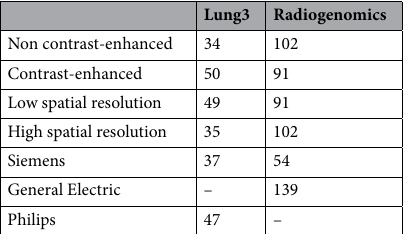
Table 5. Case counts by batch effect for the Lung3 and Radiogenomics